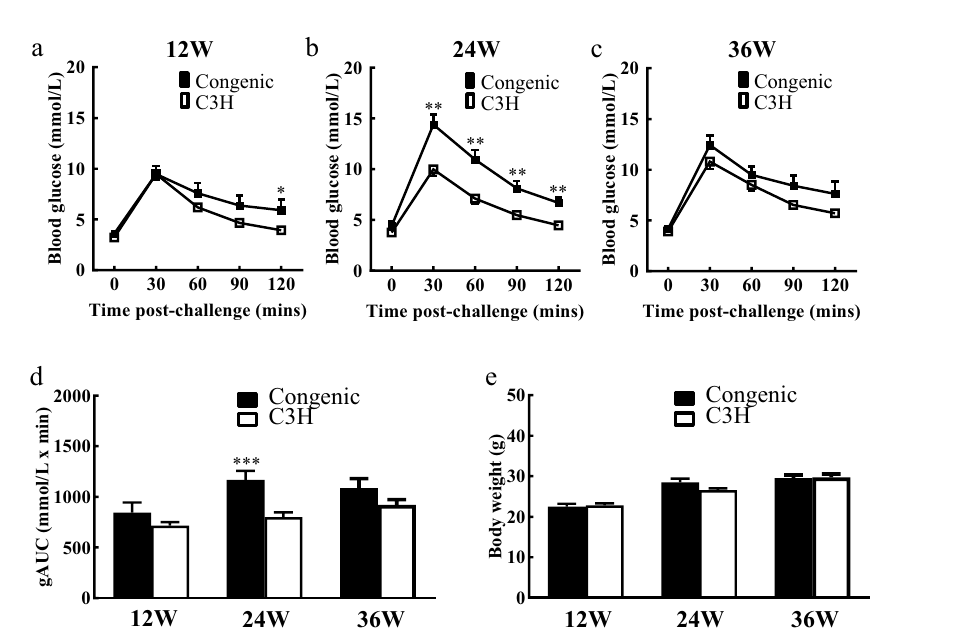
Figure 2. Longitudinal phenotypes of congenic C3H.NSY- Nidd5nsy and C3H mice. ( a–c ) Blood glucose levels after glucose challenge at ( a ) 12, ( b ) 24, and ( c ) 36 weeks of age. Closed squares, C3H.NSY- Nidd5nsy mice; open squares, C3H mice. ( d ) Area under the glucose curve (gAUC) after glucose challenge. ( e ) Body weight. The number of mice at 12, 24, and 36 weeks of age were 21, 20, and 23 in C3H.NSY- Nidd5nsy mice and 14, 22, and 10 in C3H mice, respectively. Data represent the mean ± SEM. * P < 0.05, ** P < 0.01, *** P <